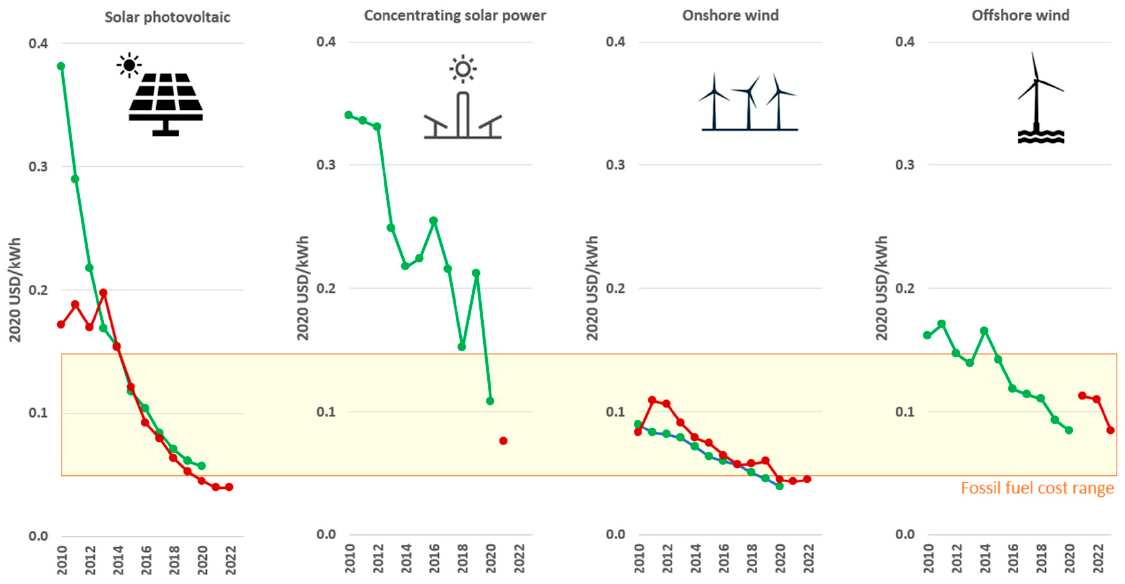
Figure 2. Global weighted-average levelised costs of energy (green) and power purchase agreement auction (red) prices for solar photovoltaic, on/offshore wind, and concentrating solar power between 2010 and 2023. Plotted from the original source [5].